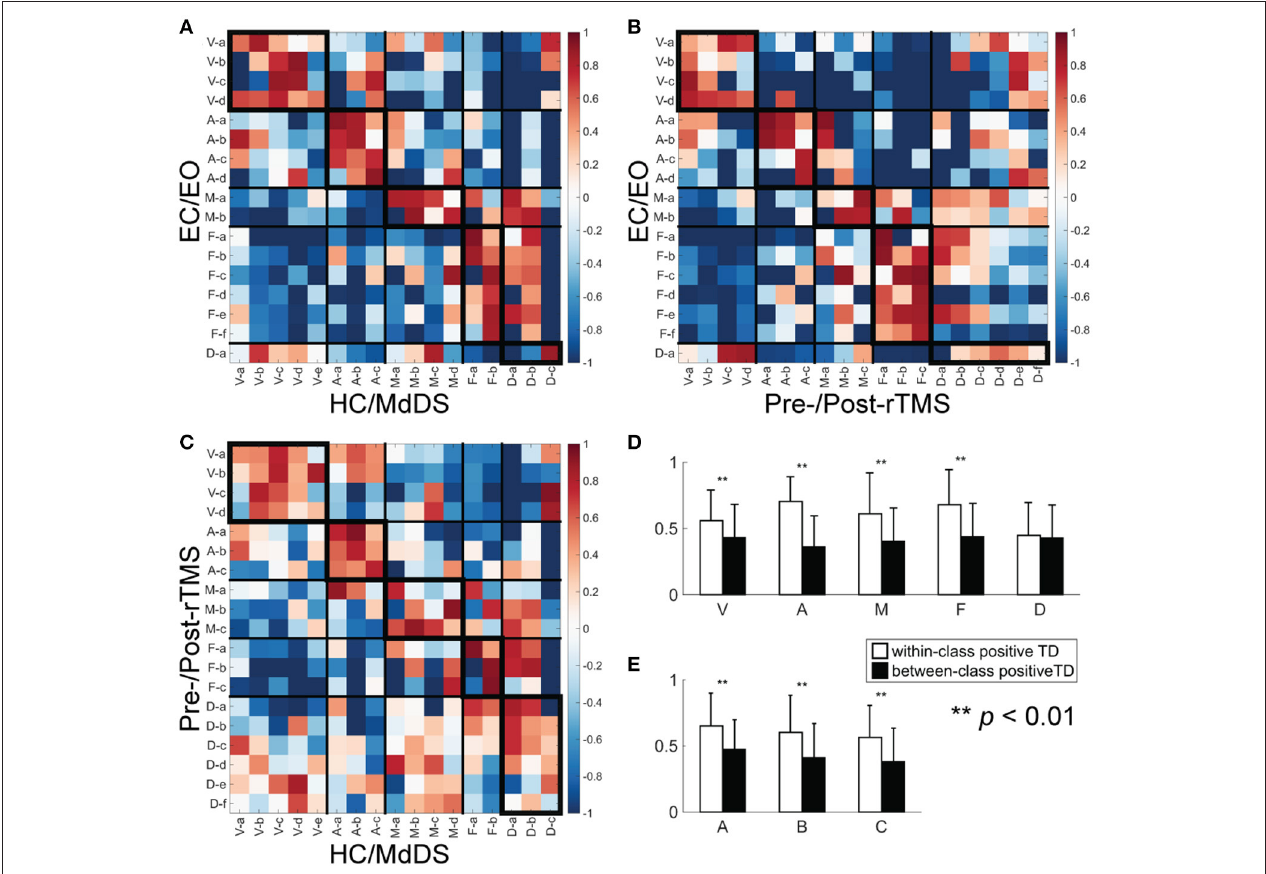
FIGURE 6 | TD between a pair of SCTs from two different datasets. (A) EC/EO vs. HC/MdDS; (B) EC/EO vs. Pre-/Post-rTMS; (C) HC/MdDS vs. Pre-/Post-rTMS; (D) Bar-plots of the within-class (enclosed with thicker boundaries) and between-class positive TDs over five RSN classes; (E) Bar-plots of the within-class and between-class positive TDs over three